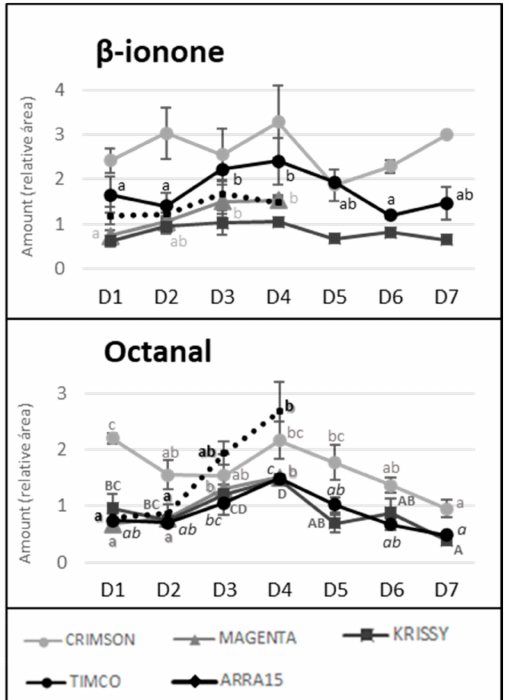
Figure 6. Evolution of β -ionone and octanal quantities along maturity and storage in all the table grapes. Di ff erent superscript letter indicates statistically significant di ff erences among the sampling times D1–D7 ( p < 0.05). Sampling along harvest: D1 , veraison; D2 , 12 DAV (days after veraison); D3 , 26 DAV; D4 , 37 DAV. Sampling along storage: D5 , 54 DOS (days of storage); D6 , 75 DOS; D7 , 108